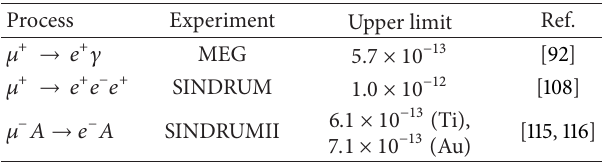
Table 1: Present experimental limits on CLFV reactions involving